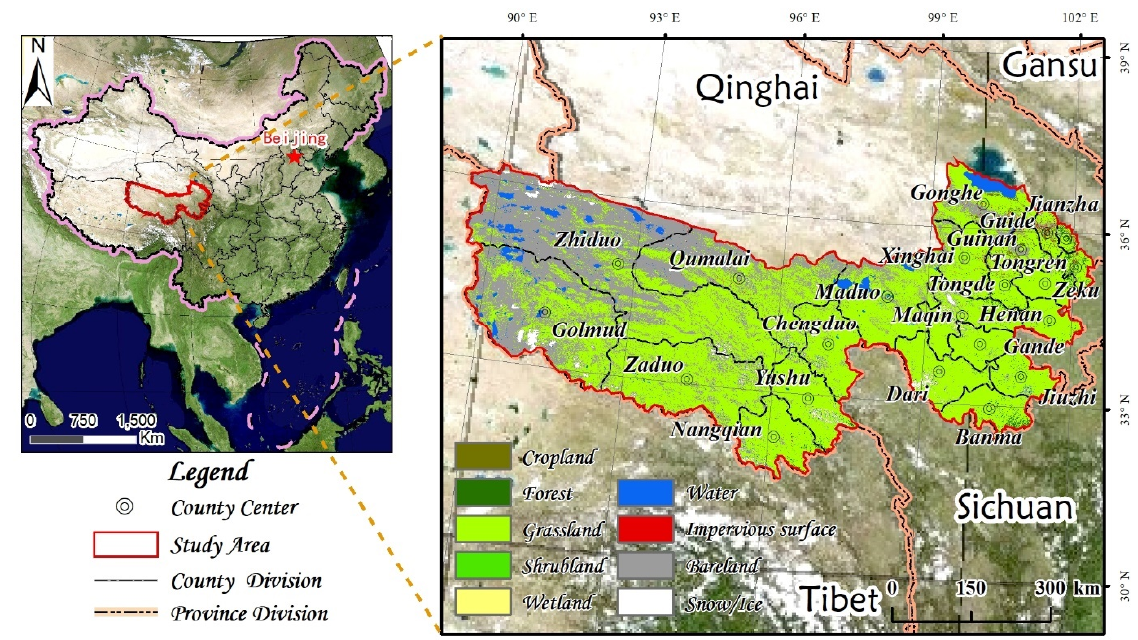
Figure 2. Study area. The land-cover maps in the right panel were published by Gong et al. [34].